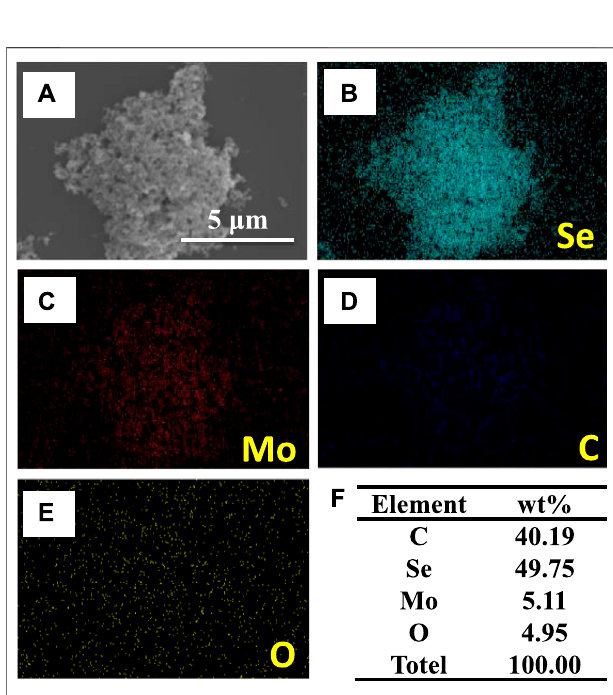
FIGURE2|(A) SEMimage, (B – E) EDSelementalmaps, and (F) derived element wt% in carbon-doped MoSe 2 nanoparticles.